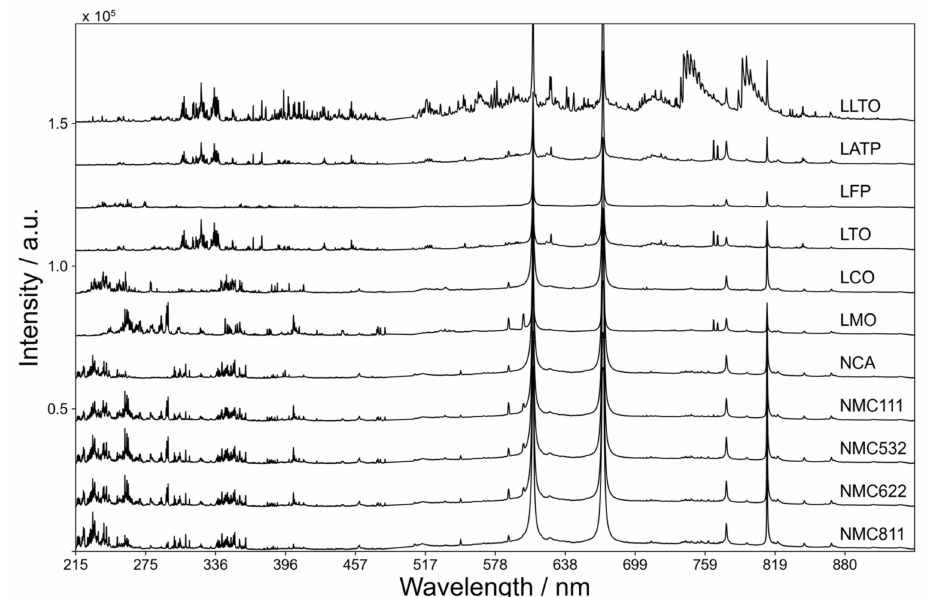
Figure 2. LIBS mean spectra of all the battery materials analyzed using the described method between 215 and 940 nm.